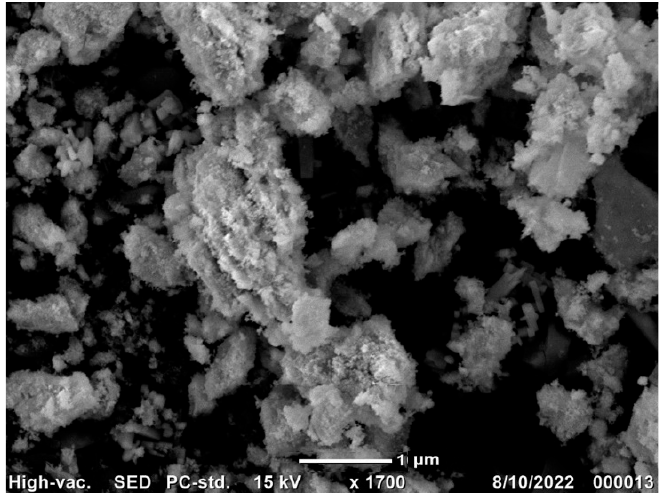
Figure 6. SEM images of ZnO nanoparticles.